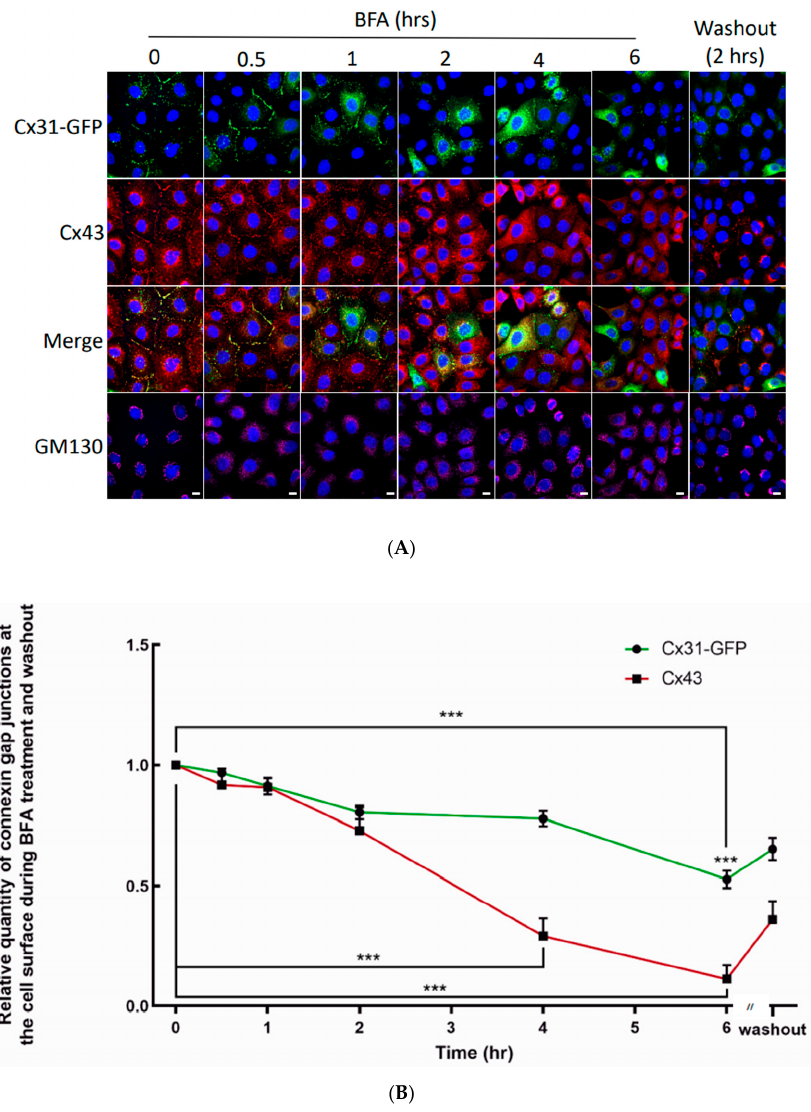
Figure 9. Cx31 gap junctions exhibit a longer lifetime on the cell surface when directly compared to Cx43 gap junctions. ( A ) REKs engineered to express Cx31-GFP were treated with BFA for up to 6 h prior to its removal and a further 2 h incubation. All cells were immunolabeled for Cx43 or GM130 to assess their intracellular distribution. Nuclei were stained with Hoechst dye. Bars = 10 μ m. ( B ) Quantification of Cx43 and Cx31-GFP gap junction plaques was assessed during BFA treatment and after BFA washout. Note that Cx31-GFP plaques persisted longer in BFA-treated cells when directly compared to Cx43. Likewise, Cx31-GFP plaque re-assembly appeared to be slower than that of Cx43 upon removal of BFA. *** p < 0.001, data plotted as ± SEM.